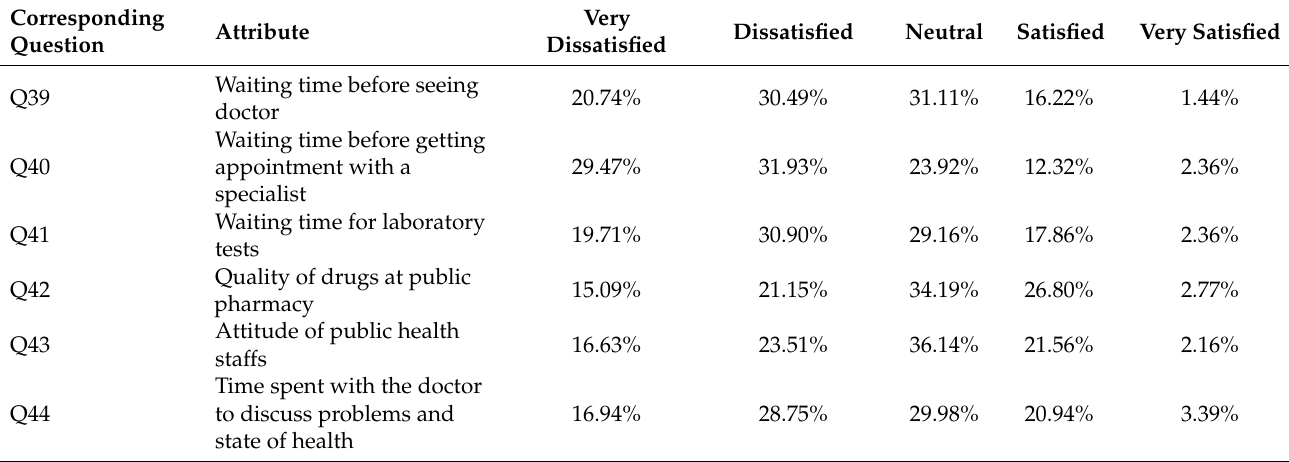
Table 4. Summary of responses on